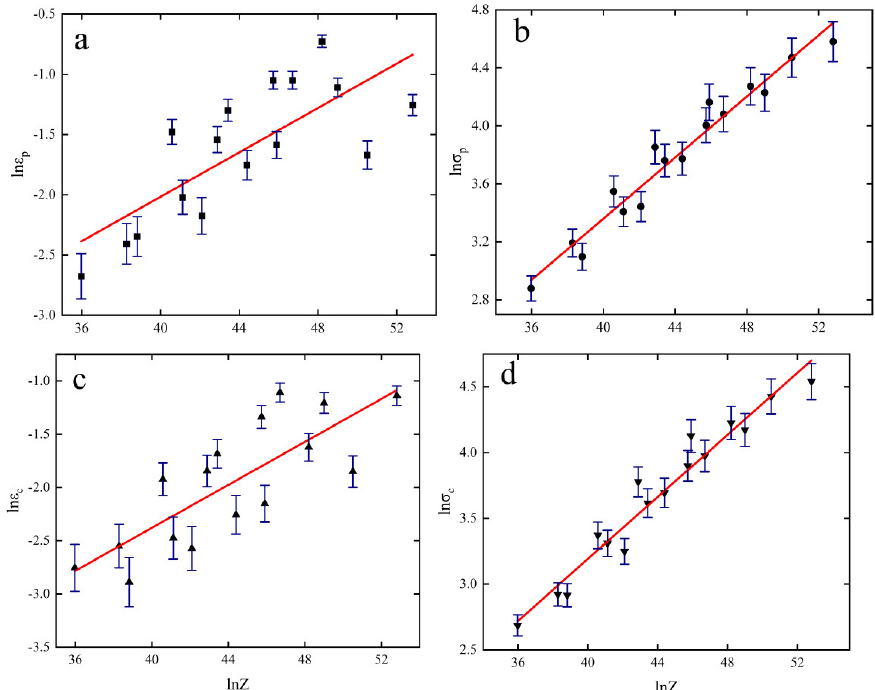
Figure 9. Fit between critical conditions and Z. ( a ) ln ε p − lnZ ; ( b ) ln σ p − lnZ ; ( c ) ln ε c − lnZ ; ( d ) ln σ c − lnZ